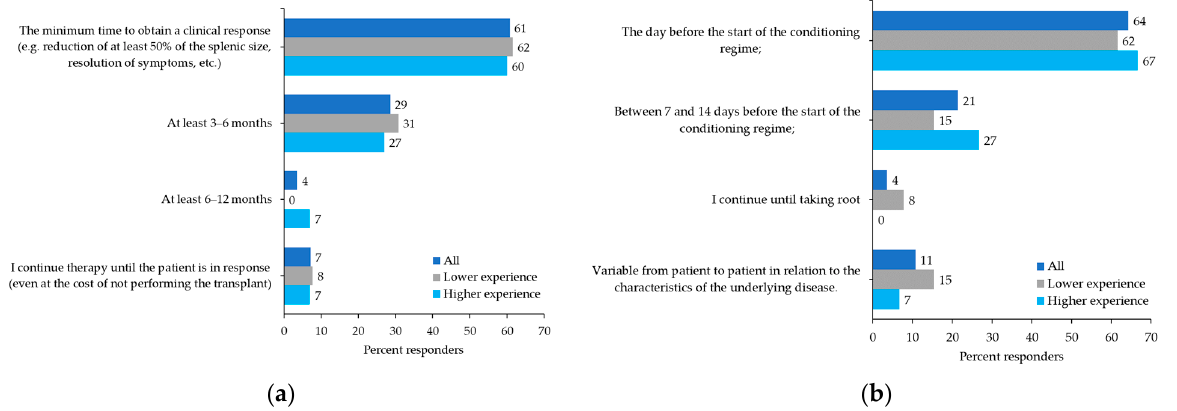
Figure 4. Participant preferences: ( a ) In an allogeneic transplant candidate patient, what do you think is the optimal period of JAK inhibitor therapy prior to transplantation? ( b ) In a transplant candidate patient, what is the timing of withdrawal of the JAK inhibitor adopted by your center?